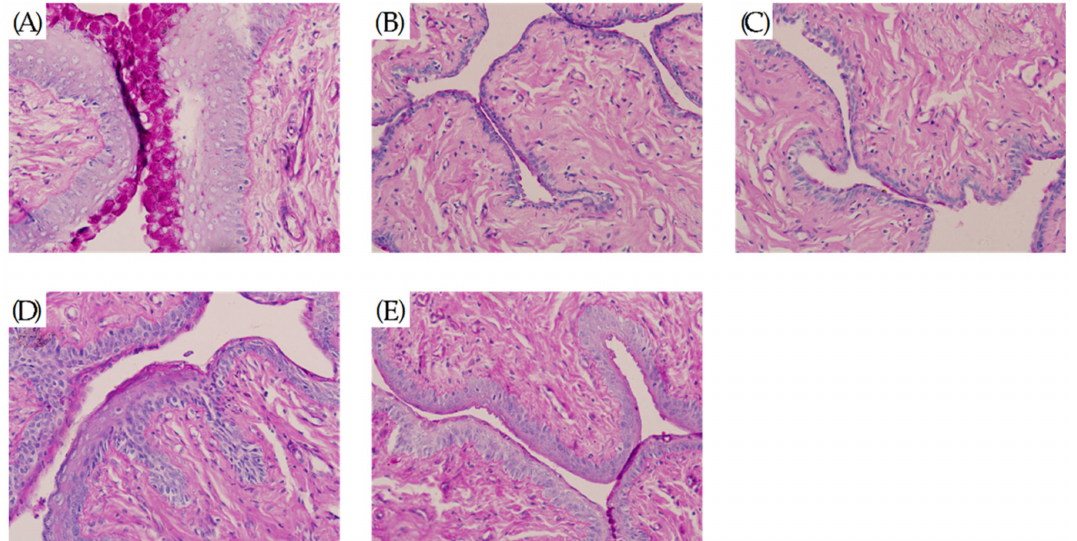
Figure 7. ( A ) Vaginal tissue from rats stained by PAS (Periodic Acid-Schiff’s reaction) showed glyco- gen enrichment in the Sham group, (40X). ( B ) Vaginal tissues from rats stained by PAS showed mini- mal glycogen content in the M group, (40X). ( C ) Vaginal tissues of rats stained with PAS showed little glycogen in the K group, which was not significantly different from the M group, (40X). ( D ) Vaginal tissues of rats stained with PAS showed increased glycogen content in group Y compared to group M, (40X). ( E ) Vaginal tissues of rats stained with PAS showed increased glycogen content in group Gen compared to group M,